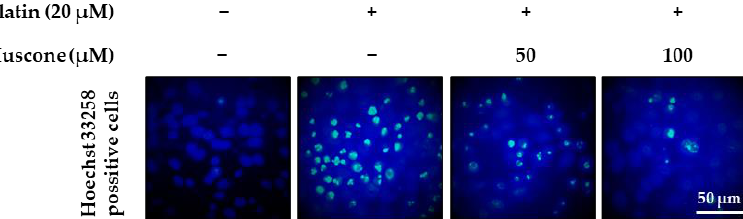
Figure 5. Protective effect of muscone against cisplatin-induced chromatin condensation in kidney proximal tubule LLC-PK1 cells. LLC-PK1 cells were exposed to muscone in the presence or absence of 20 µM cisplatin for 8 h and dyed with Hoechst 33258. Fluorescent images were captured using a fluorescent microscope (scale bar: 50 µ m).